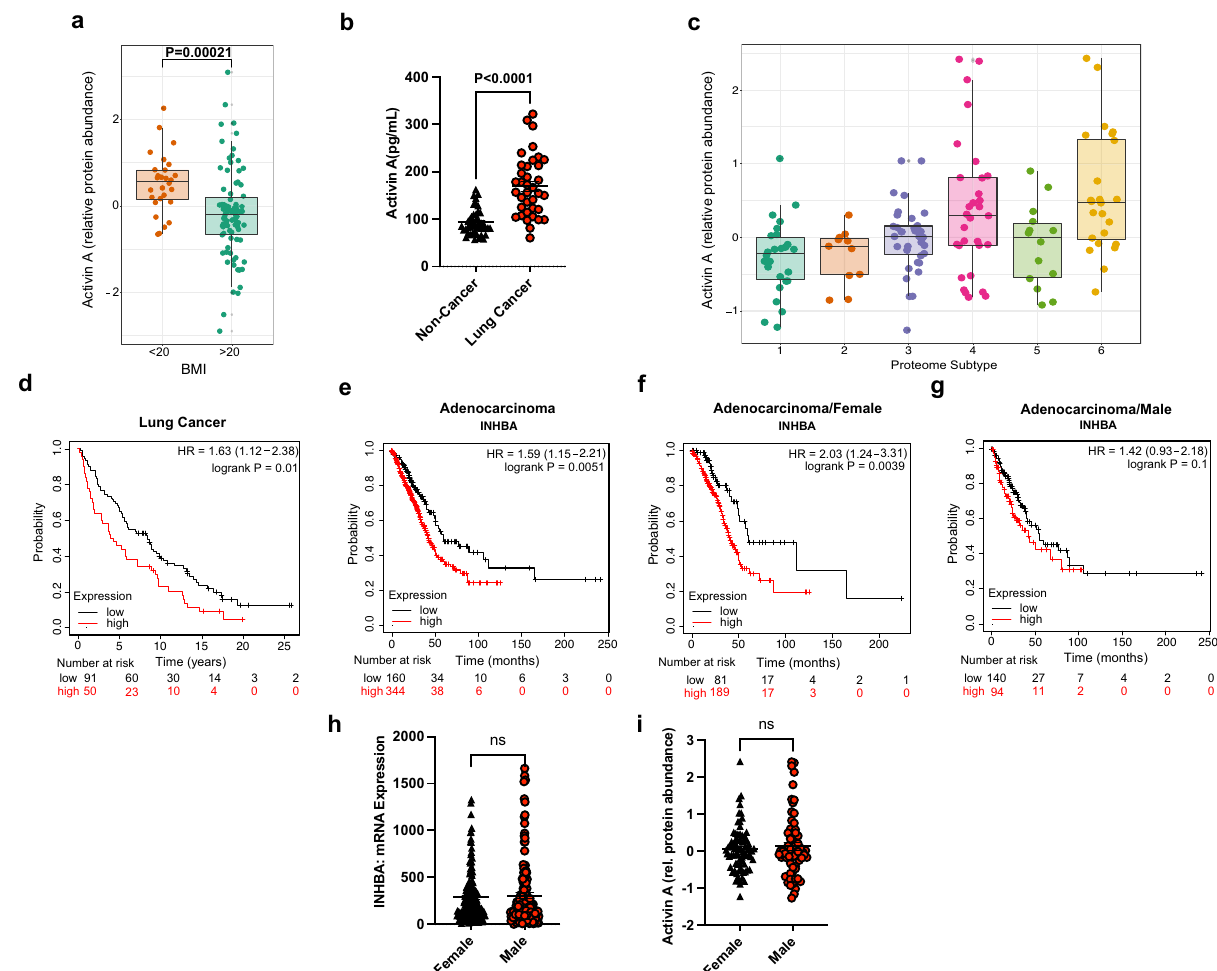
Fig. 6 | ActivinA expressionin humanlung adenocarcinoma is associated with poor prognosis only in female patients. a Activin A relative protein abundance in lung tumors from CPTAC categorized by a BMI cutoff of 20 (BMI ≤ 20, n =28; BMI>20, n =81). b Serum ActivinA levels measured by ELISA in acohort of lung cancer patients from Weill Cornell( n =82). c Lung cancer Activin A relative protein abundance categorized by proteogenomic subtype de fi ned by Lehtiö et al. ( n =141). d Kaplan-Meier (KM) plot with the probability of survival of patients ( n =141) with high or low Activin A protein levels published by Lehtiö et al. e KM plot with the probability of survival of patients with adenocarcinoma with high or low Activin A protein levels from TCGA ( n =504). f , g KM plots with the probability of survival of patients with adenocarcinoma with high or low INHBA expression levels divided in Females ( f , n =270) and Males ( g , n =234).